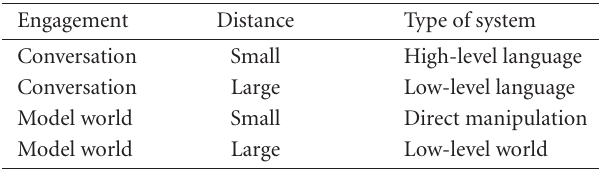
Table 1: Interaction systems.